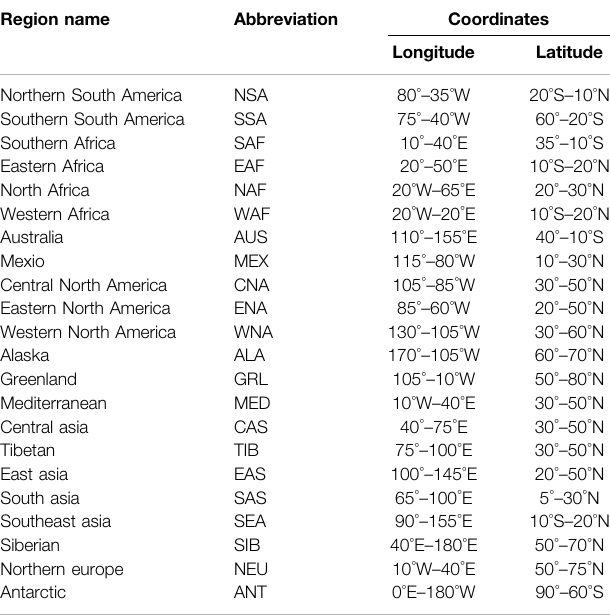
TABLE 2 | Names and coordinates for the 22 regions in the continents. Region